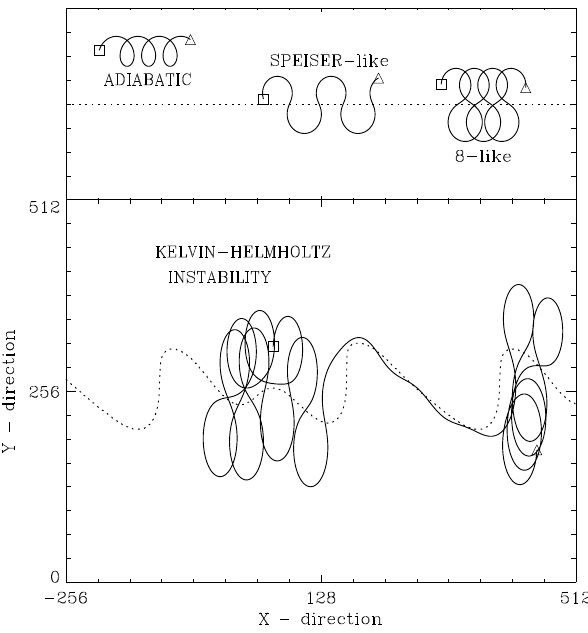
Fig. 12. Different orbit types in a tangential discontinuity: (1) adia- batic, (2) Speiser-like and (3) figure eight-like (upper panel). KH in- stability essentially allows transition between these d ifferent types of motion (lower